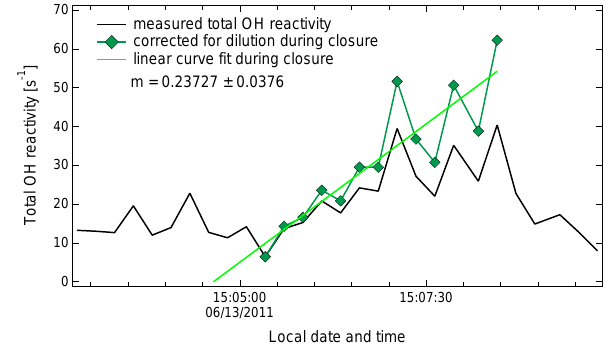
Fig. 2. Example for total OH reactivity emission (TOHRE) cal- culation: the originally measured total OH reactivity (black line) varied for open cuvette measurements between 10–20s − 1 ; during closure it increased to 40s − 1 . The dilution during cuvette closure due to leaking in of atmospheric air suppresses the measured total OH reactivity stronger the longer the system is closed. A dilution correction is applied (green markers) before fitting the closure data with a linear regression line (green line). Slopes, uncertainty of the slopes, and fit quality are obtained for each